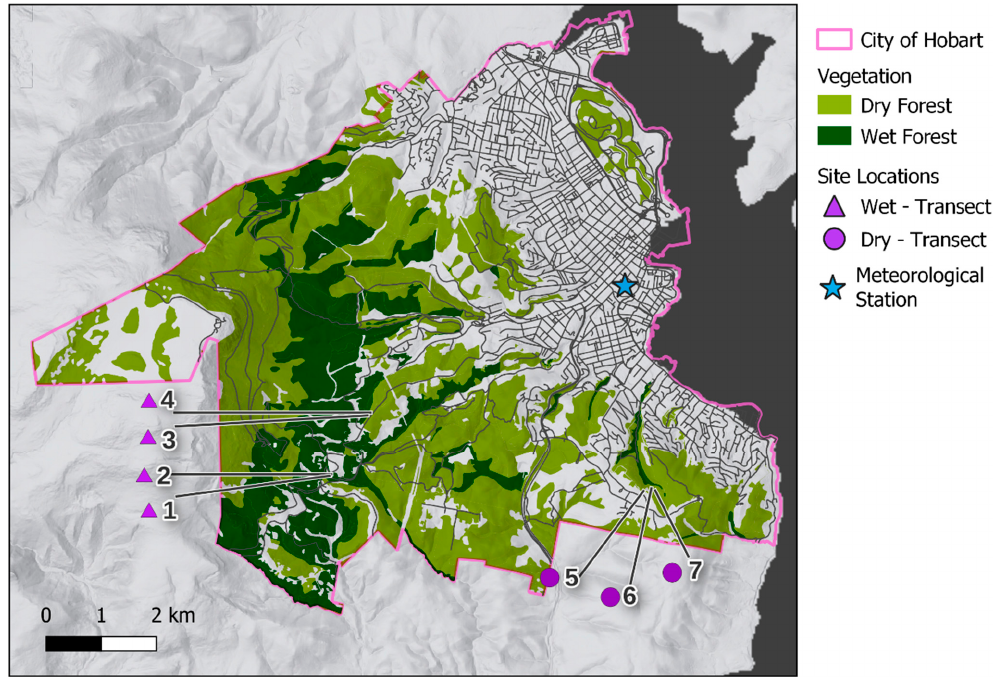
Figure 1. Map of city of Hobart study area with location of wet and dry forests and non-forest land use. Transect site locations (numbered 1 to 7) are indicated, refer to Figure 2 for details. The location of the meteorological station used for the soil dryness index is indicated; note it is not representative of the forest environment, being at lower altitude and in close proximity to the coastal environment that experiences a more maritime climate.